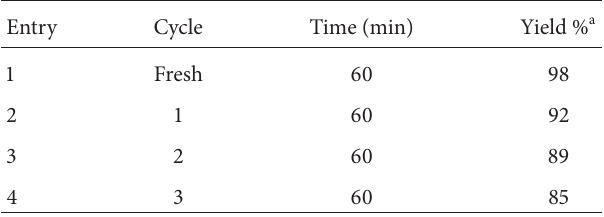
Table 6: Recycling studies of reaction between benzaldehyde, kojic acid, and indole in the presence of Kaolin/Ag nanocomposite to give product 4a